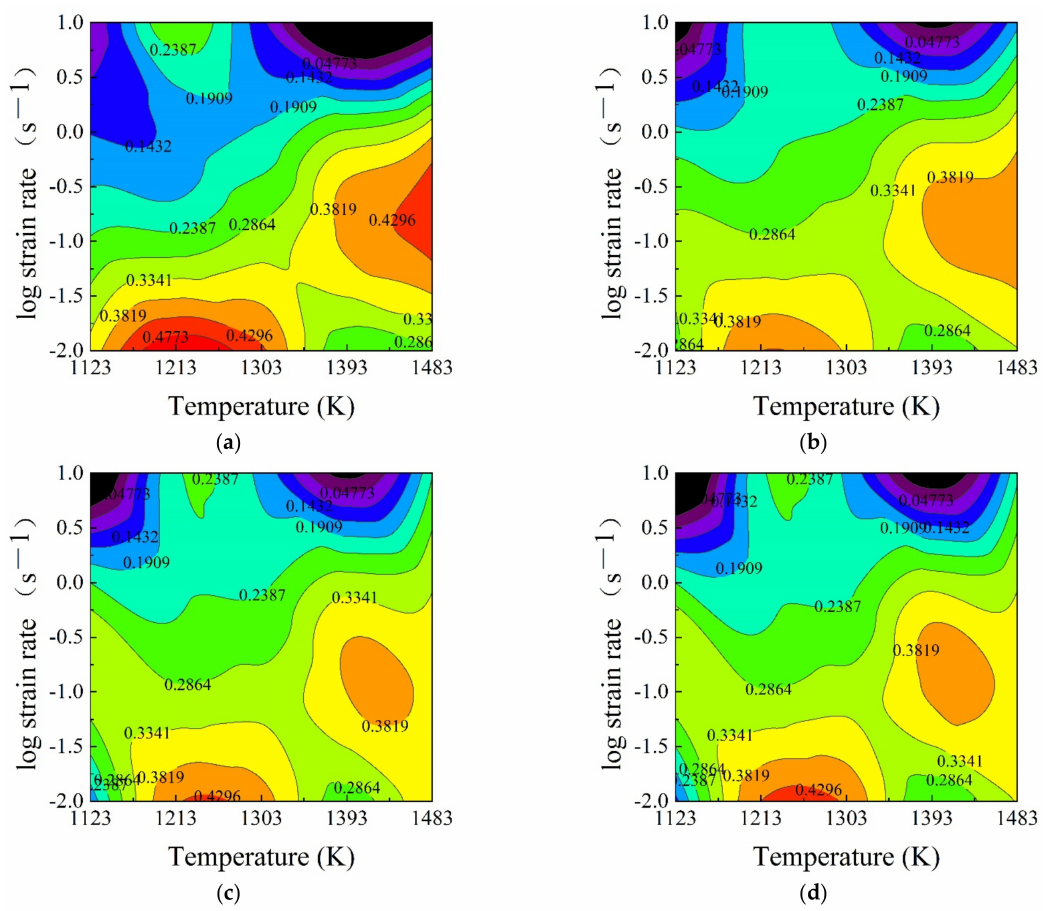
Figure 7. 2D power dissipation maps for SAE 5137H steel under different true strains of ( a ) 0.3; ( b ) 0.5; ( c ) 0.7; and ( d )